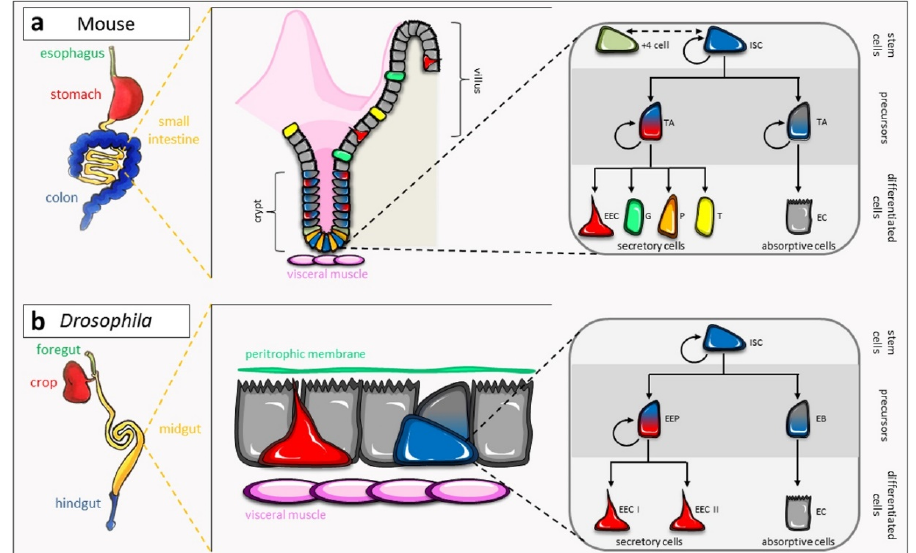
Figure 1. Cellular organization and lineages of the mouse small intestine and the Drosophila midgut. ( a ) The small intestine of the mouse is organized as units made of crypts and villi. ISC, localized at the bottom of the crypts, and transit-amplifying precursors (TA) proliferate to generate mature cells (enteroendocrine cells—EEC, goblet cells—G, Paneth cells—P, tuft cells—T, enterocytes—EC) through two distinct lineages, forming the secretory cells and the absorptive cells. Whereas Paneth cells migrate to the bottom of the crypt, the other differentiated cells migrate up to the villi. ( b ) The midgut of Drosophila is a flat epithelium. Two types of precursors are generated from ISC divisions, the enteroendocrine precursors (EEP) and the enteroblasts (EB), which give rise to the secretory enteroendocrine cells (class I and class II) and the enterocytes, respectively. The peritrophic membrane has an equivalent role as